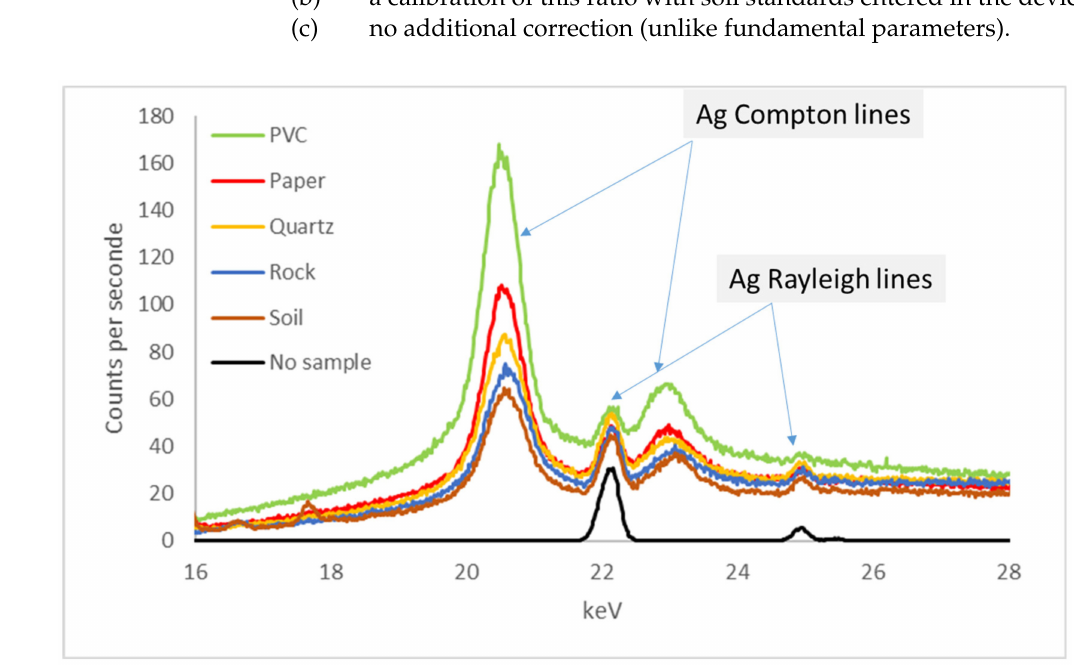
Figure 3. Compton peaks in the Ag fluorescence X-ray spectra of different materials (PVC, Paper, Quartz (SiO 2 ), Rock (Gran- ite), Soil (NIST2711a) and No sample (Control